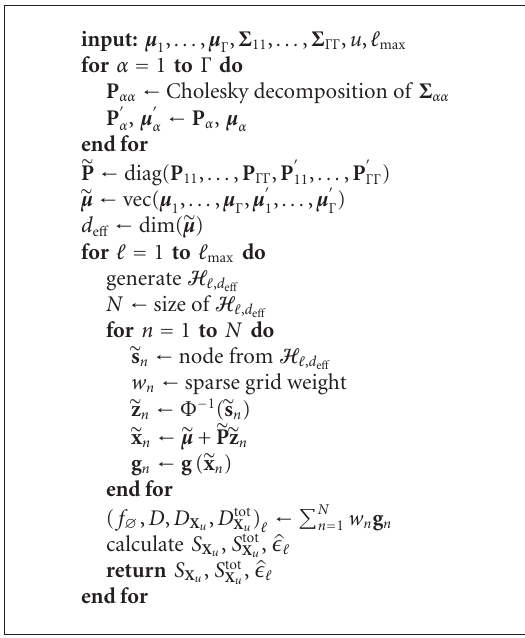
Algorithm 2: The calculation of sensitivity indices using sparse grid